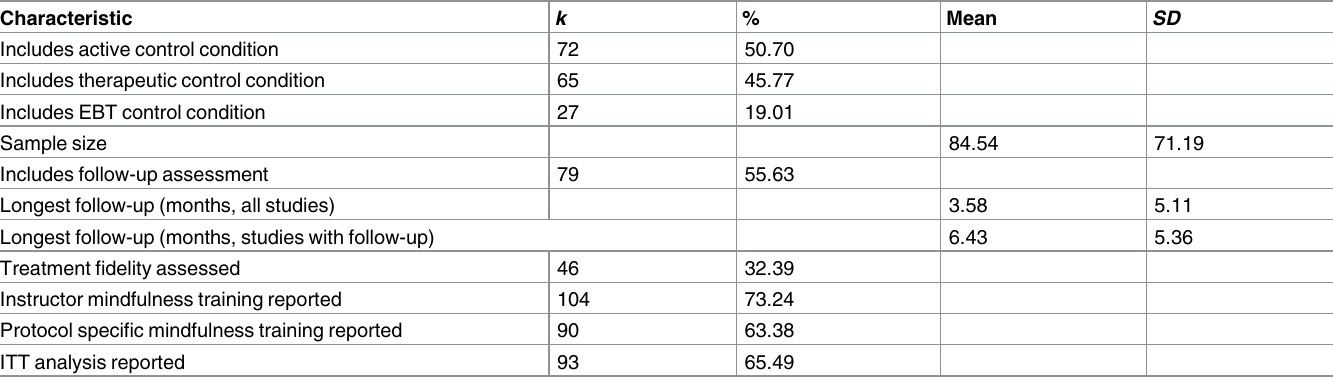
Table 1. Study quality descriptive statistics.